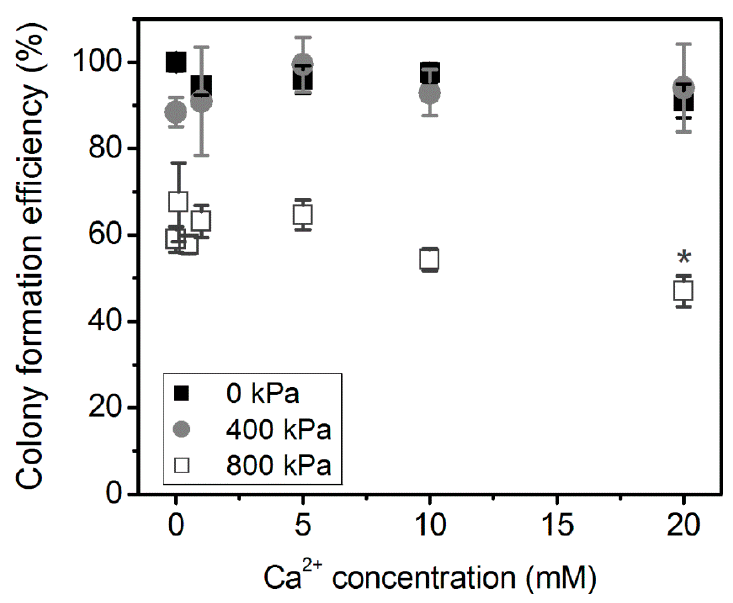
Figure 3. The effect of different Ca 2+ concentration on cell colony formation efficiency: without US exposure (0 kPa) and with US exposure (400 and 800 kPa acoustic pressure). * indicates statistical significance ( p < 0.05) between 0 and 20 mM Ca 2+ concentration groups at 800 kPa acoustic pressure. US irradiation (0 kPa) in the range of concentration of 0–20 mM had no effect on cell